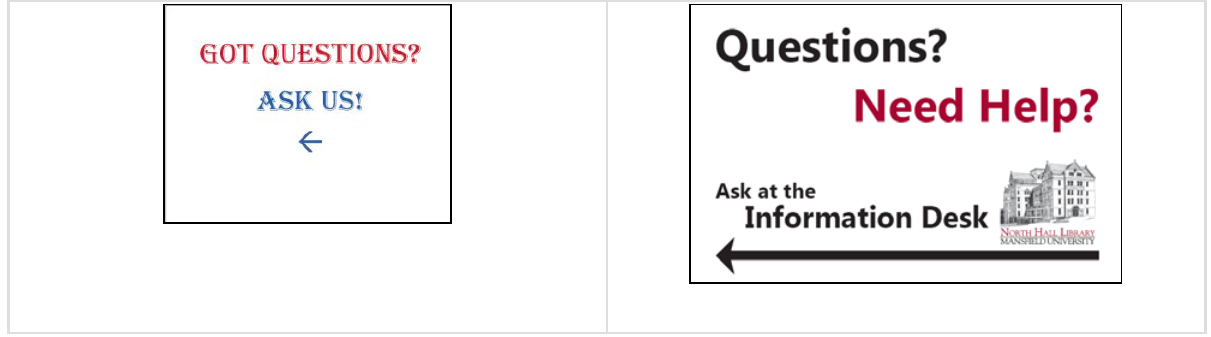
The original main entrance sign (left). The new main entrance sign (right) is more welcoming. It sets the tone for the library with the wording, and it is the first use of the library logo and design specification.